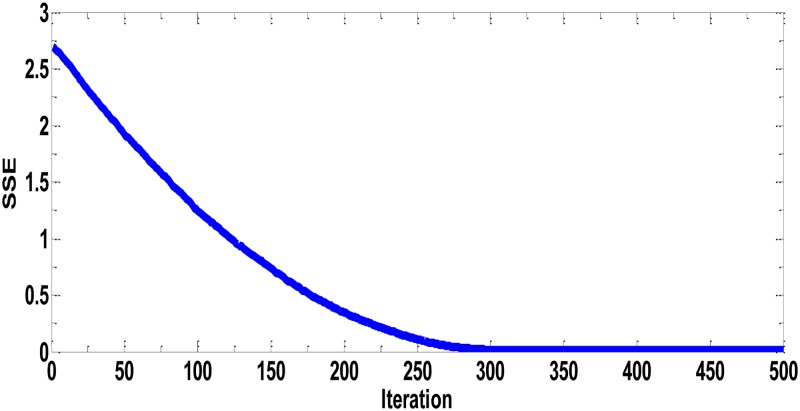
Best performance of prey predator algorithm in terms of sum of squared error for PVP with different wt. % (MWCNTs) SSE = 0.0029.